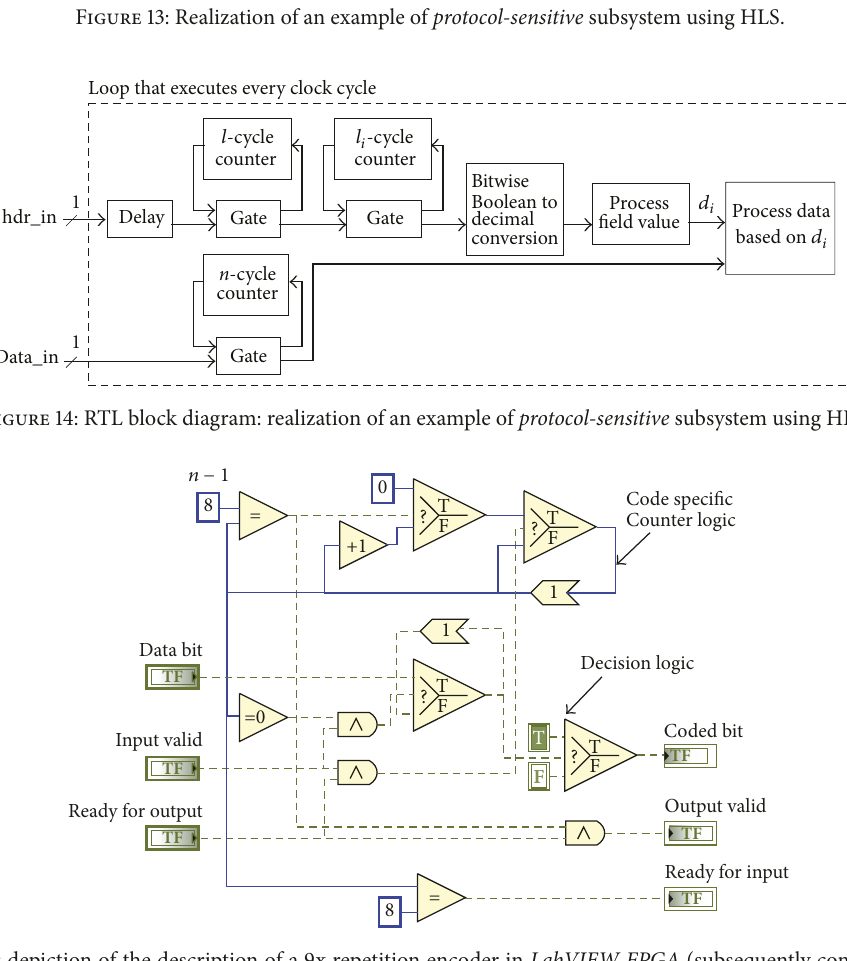
Figure 15: Schematic depiction of the description of a 9 x repetition encoder in LabVIEW FPGA (subsequently compiled to VHDL ). Note that the logic required is specific to the codeword size 𝑛